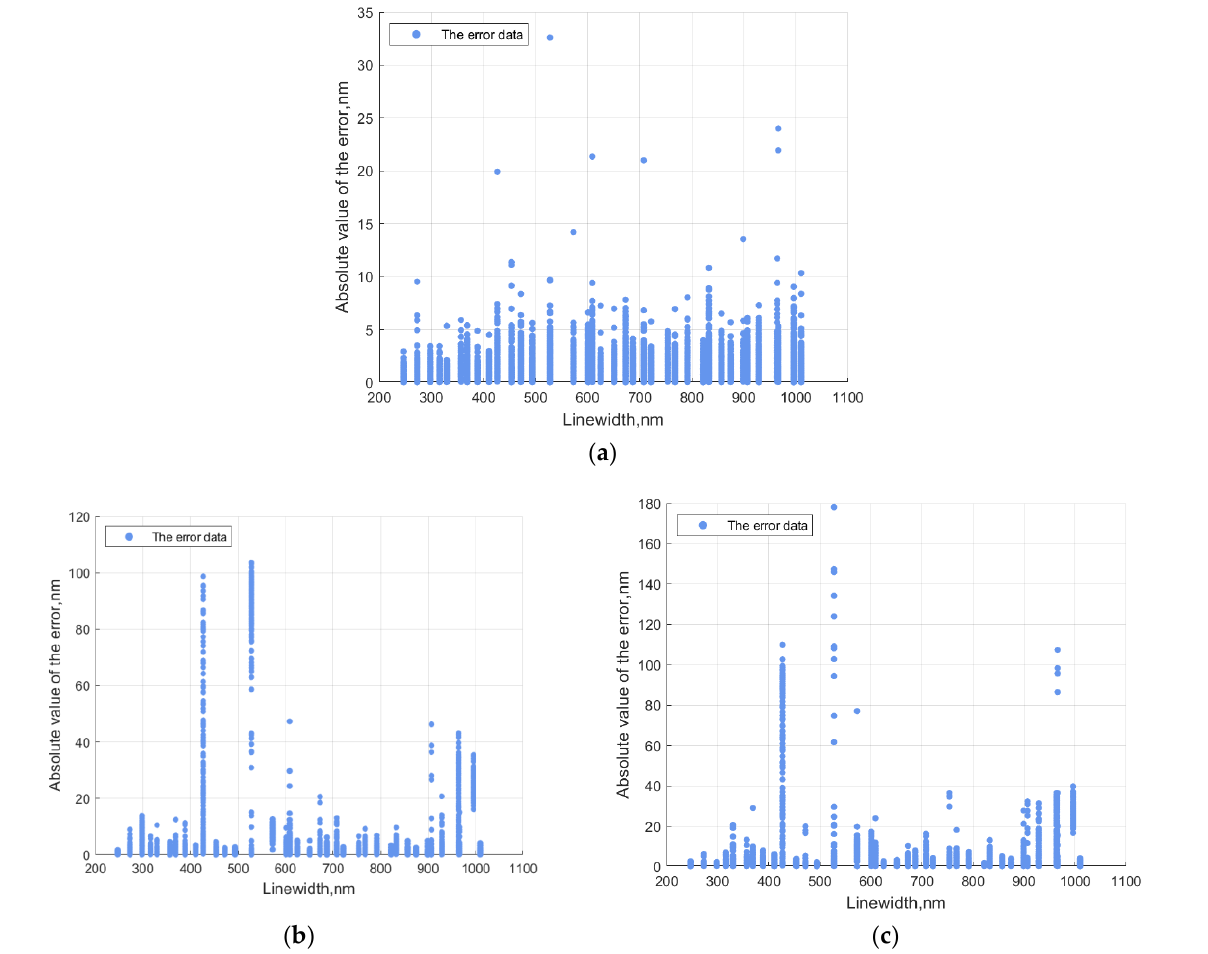
Figure 11. The measuring performance of three different TSOM methods on the test set. ( a ) Focus & TSOM-CNN; ( b ) ResNet50; ( c ) DenseNet121.